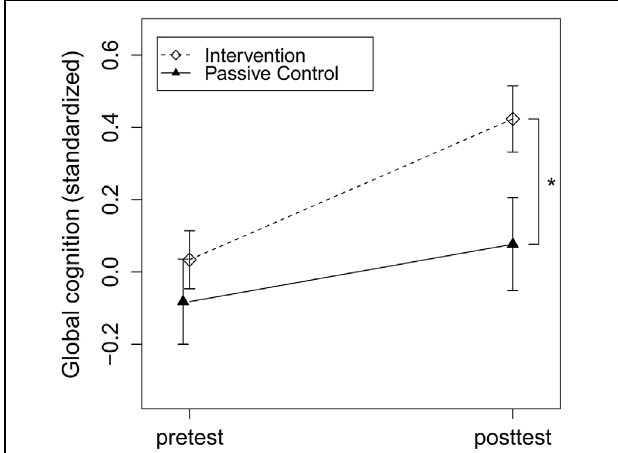
FIGURE 2 | Intervention effects on global cognition. Intervention and passive control group comparison of z -standardized pre- and post-test global cognition. The asterisk indicates a significant beneficial effect of the intervention compared to the control group on post-test performance accounted for baseline cognitive performance, education, age and study center, p = 0.002, Cohen’s d = 0.31. Arrows represent SE.